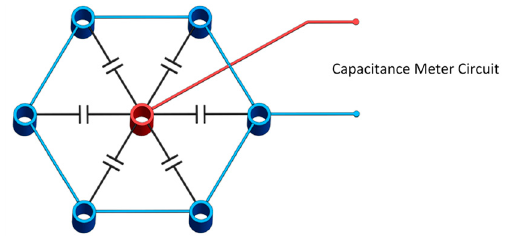
Figure 2. Single-sensor configuration.